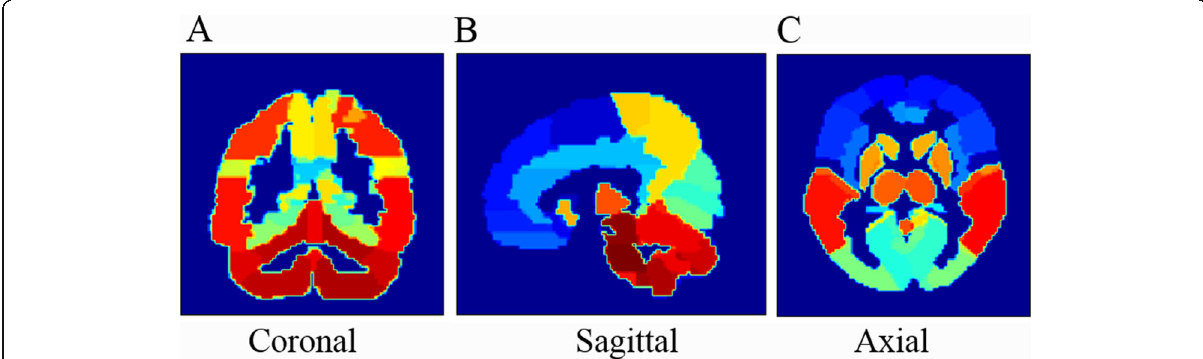
Fig. 1 The brain atlas template, which segments the brain into 70 regions, labeled with numbers from 1 to 70 and showed with different